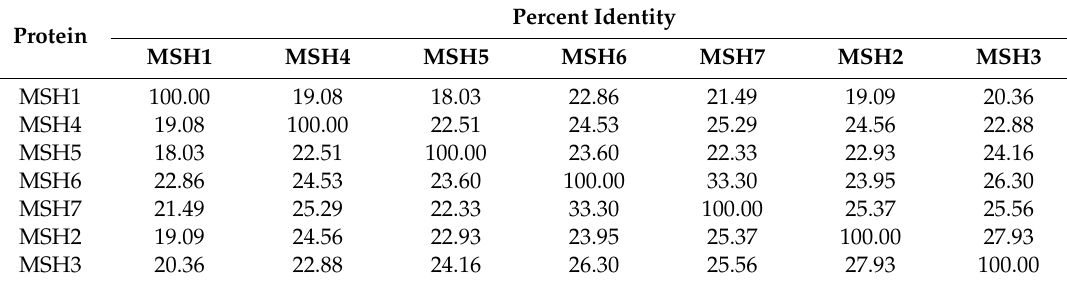
Table 1. The identity matrix percent of similarities among AtMSH proteins.